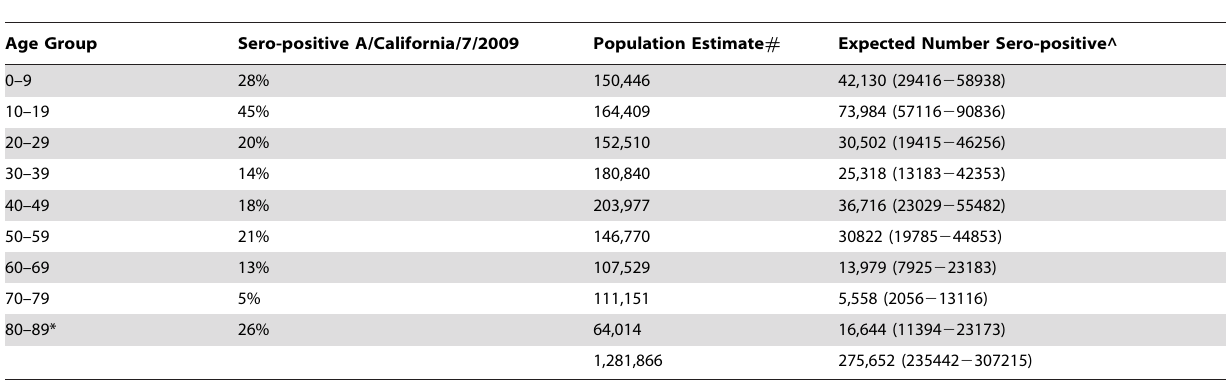
*Includes everyone over 85. # Population estimates taken from US Census (2000).